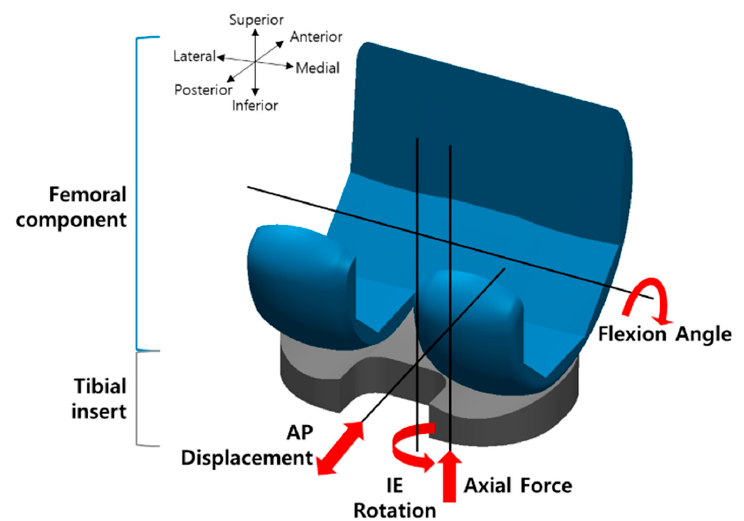
Figure 7. Boundary and loading conditions of the FE model used in this study